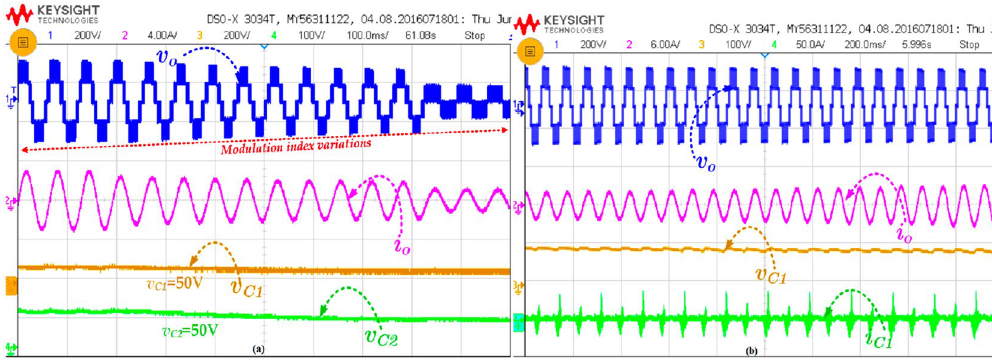
Figure 10. Experimental result of ( a ) modulation index variations and ( b ) load variations.